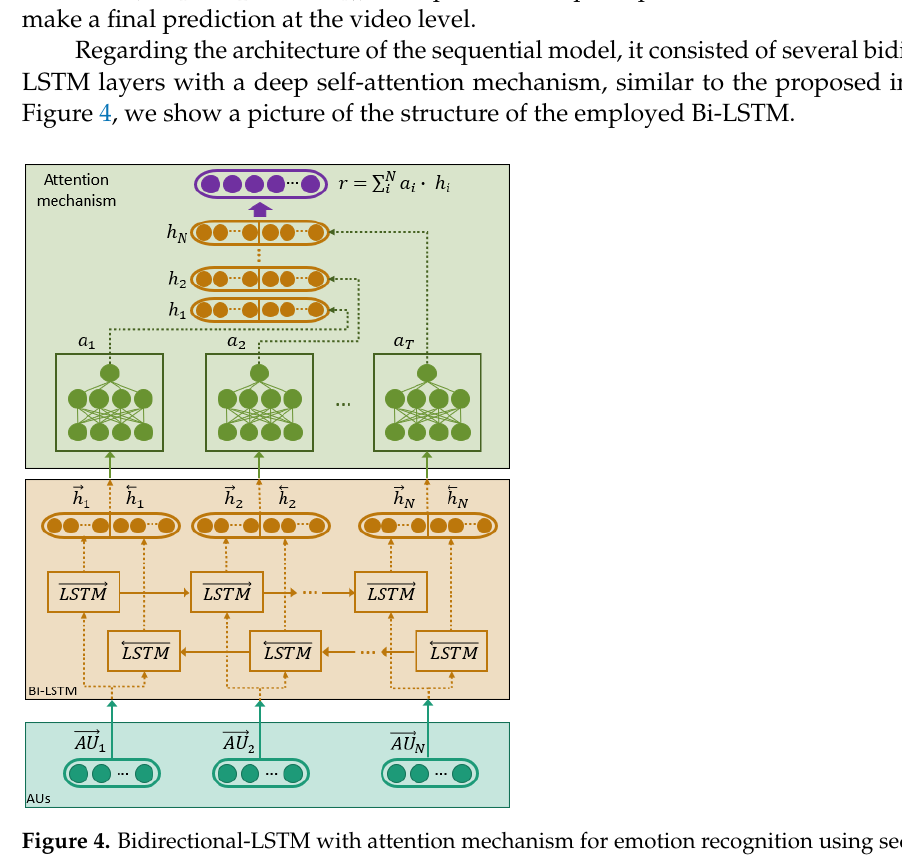
Figure 4. Bidirectional-LSTM with attention mechanism for emotion recognition using sequences of Action Units at the input. Modified version from source